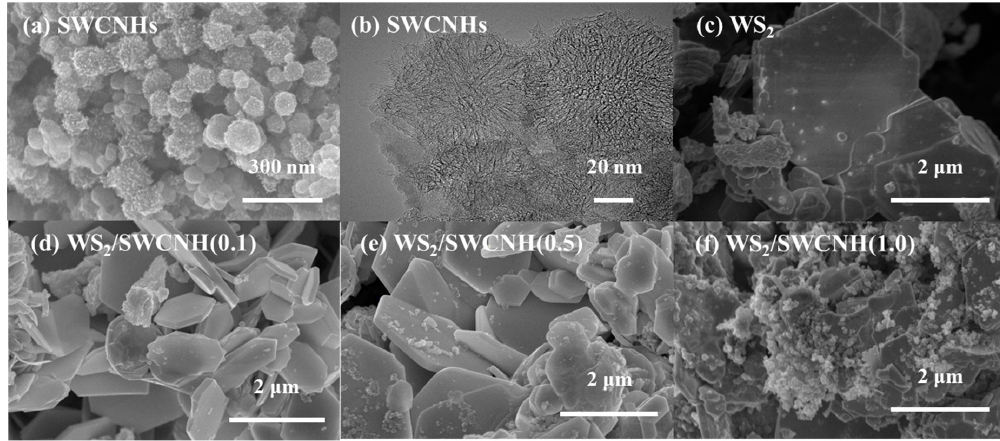
Figure 2. ( a ) Field emission scanning electron microscopy (FE-SEM) and ( b ) high-resolution